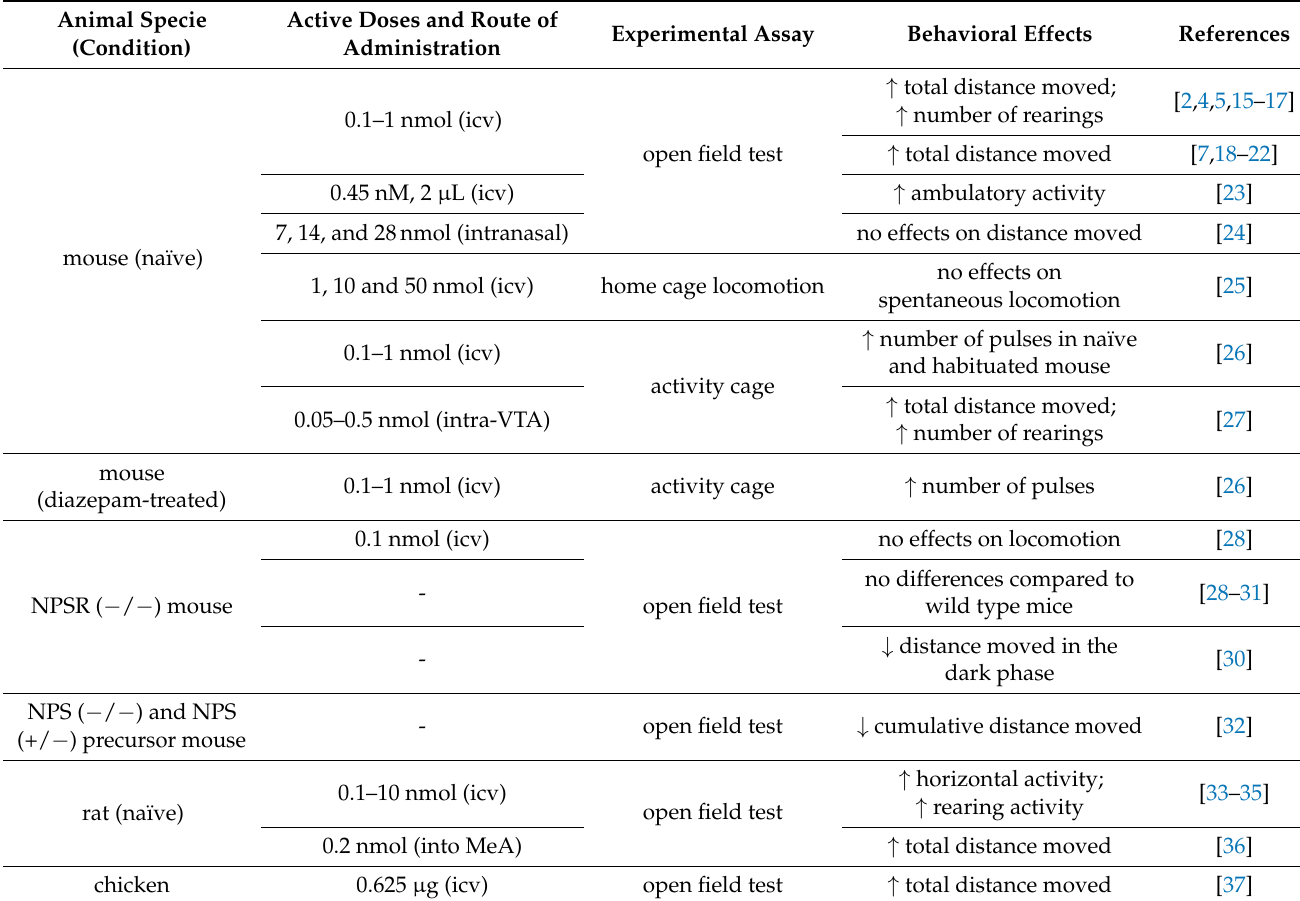
Table 1. Effects of Neuropeptide S (NPS) on spontaneous locomotion and exploration of animals in novel and familiar